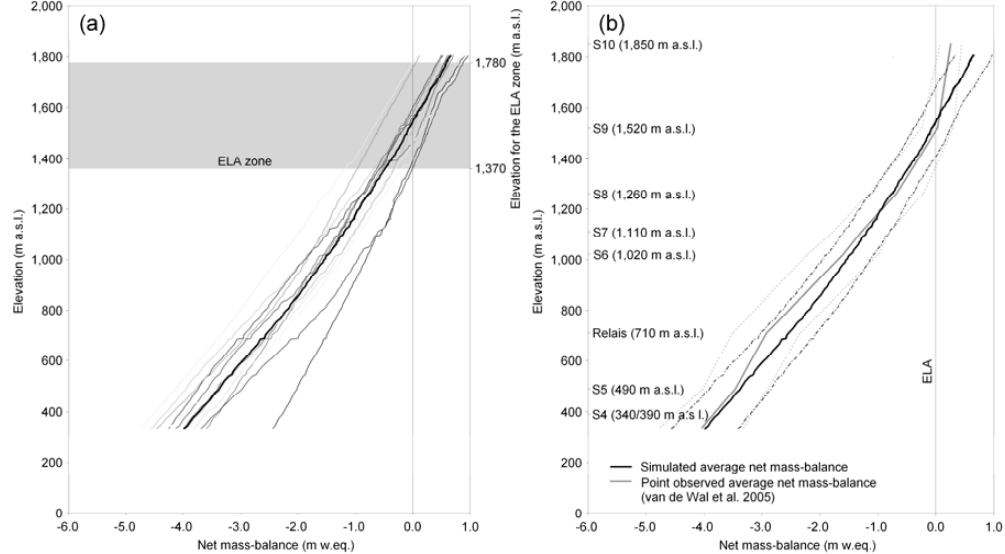
Fig. 2. (a) Simulated GrIS net mass-balance in relation to elevation for the Kangerlussuaq drainage area for the period 1990 through 2003 (similar to the period of observed net mass-balance published in van de Wal et. al 2005). The different years are not displayed individually; (b) a comparison between Kangerlussuaq GrIS simulated net mass-balance and point observed net mass-balance from the K-transect. The observed values are collected at different elevations from the K-transect as listed in figure b. The dotted lines in figure b indicate one standard deviation for both simulated and observed values.